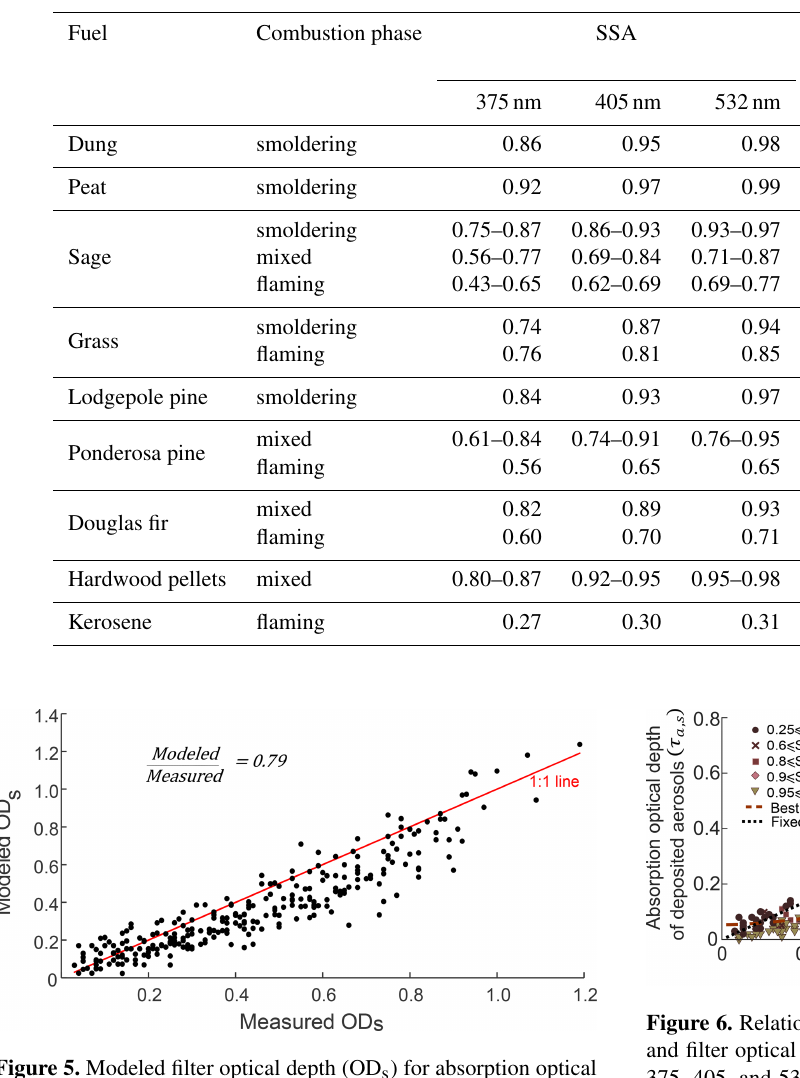
Figure 5. Modeled filter optical depth (OD s ) for absorption optical depth and single scattering albedo values of the aerosols sampled in this study compared with the corresponding filter measurements. A 1 : 1 line is shown in red. The average ratio of modeled to measured OD s is 0.79.